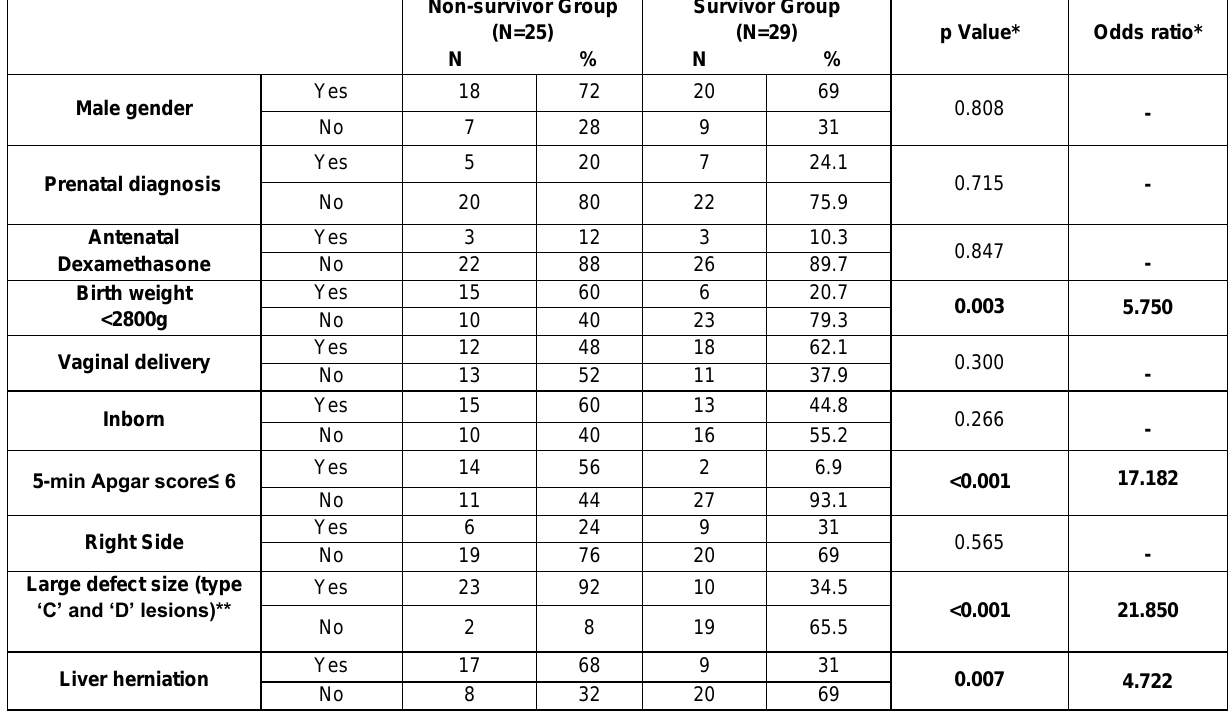
Table 1: Post-natal factors associated with 30-day mortality in patients undergoing surgical repair for congenital diaphragmatic hernia Non-survivor